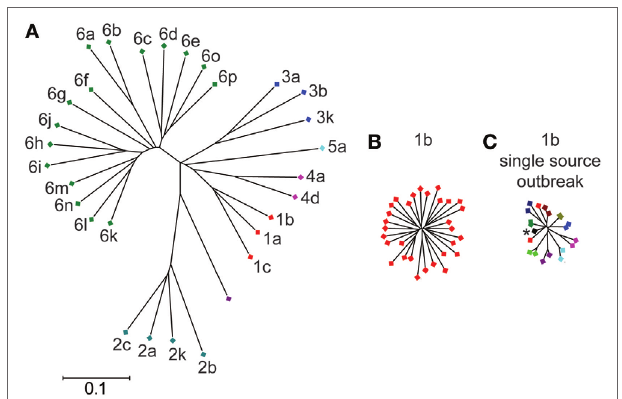
FiGURe 1 | Genetic diversity of hepatitis C virus (HCV) E1E2 across subtypes and within a single subtype. Phylogenetic trees of E1E2 amino acid sequences. E1E2 amino acid sequences from multiple subtypes (A) or a single subtype (B) were downloaded from the LANL HCV sequence database. Not all known subtypes are shown. (C) E1E2 amino acid sequences of 10 individuals from the Irish anti-D cohort, who were all infected from the same inoculum (asterisk) between 1977 and 1978 (9). Sequences of virus from each individual are indicated with a different color. Trees were inferred using the Neighbor-joining method, with branch lengths drawn to scale. Subtypes are labeled. All three trees are on the same scale. Distances were computed using the JTT method. Analyses were performed in MEGA7